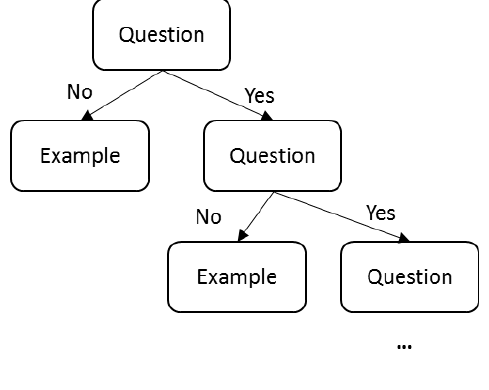
Figure 8 . Structure of troubleshooter for programming